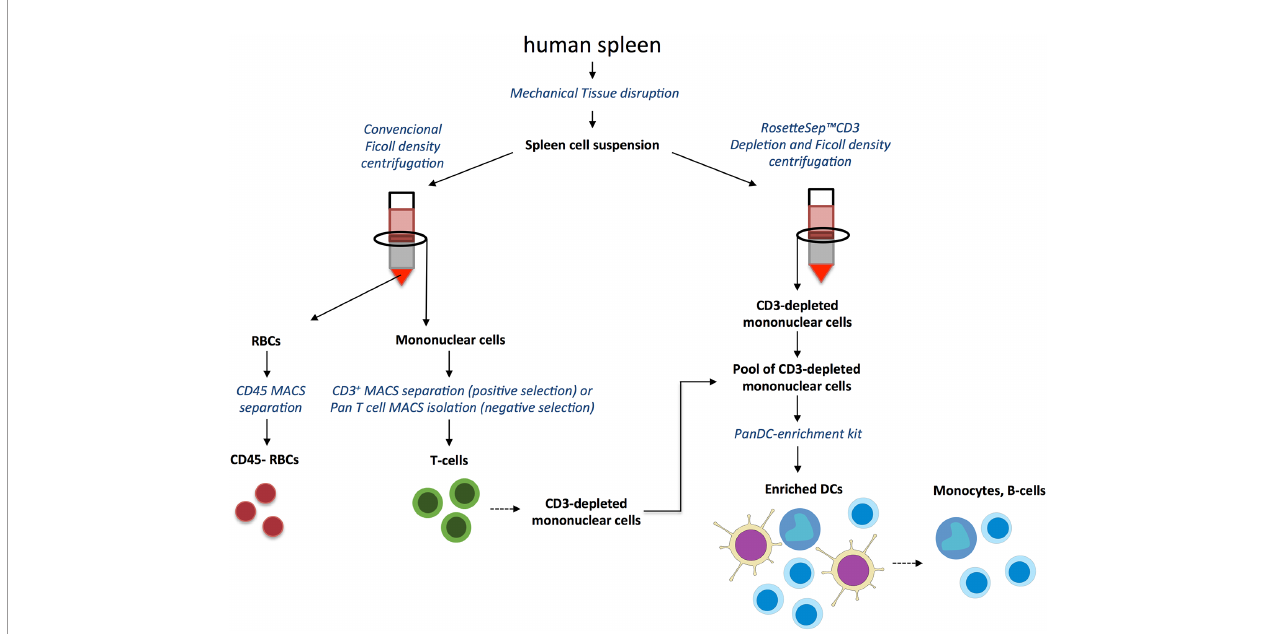
FIGURE 2 | Human spleen T cells, dendritic cells and red blood cells puri fi cation strategy. Human spleen was processed to produce a single cell suspension by mechanical tissue disruption and exhaustive fi ltration. Cell suspensions were processed by conventional Ficoll density centrifugation to isolate mononuclear cells from which T cells were enriched by positive selection with anti-CD3-magnetic beads or by negative selection using Pan-T Cell Isolation Kit. Post-Ficoll sedimented RBCs were further puri fi ed by negative selection using anti-CD45 magnetic microbeads to deplete leukocytes. In parallel, DCs were enriched by a fi rst step of T cells depletion using RosetteSep ™ CD3 Depletion Cocktail followed by Ficoll density gradient centrifugation. By mixing the CD3- depleted mononuclear fraction obtained by Rossette sep ™ and CD3 - depleted cells from the fl ow-through of CD3-positive selection described above we composed a CD3 - mononuclear cells pool. DCs were then enriched from the CD3 - pool by negative selection using the EasySep ™ Pan-DC Pre-Enrichment Kit. The retained fraction rich in monocytes and B cells was also included in the EVs in vitro interaction